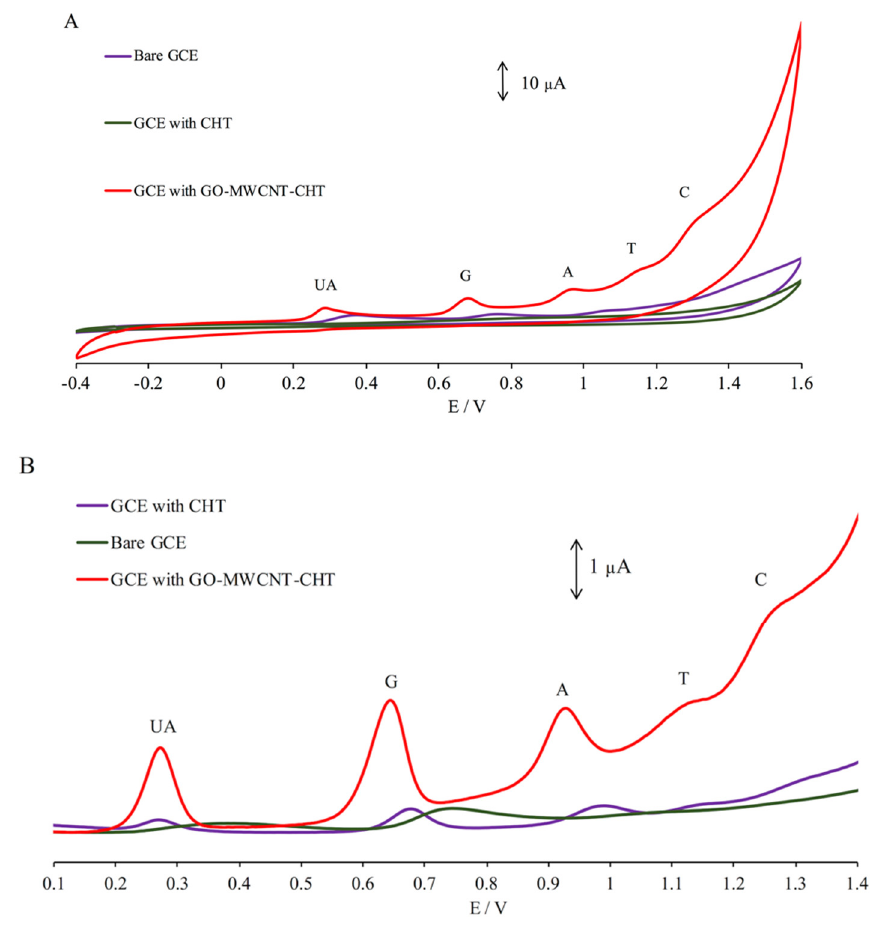
Figure 5. ( A ) Comparison of CV using bare GCE, GCE / CHT, and the GCE / GO-MWCNT-CHT to detect Figure 5. ( a ) Comparison of CV using bare GCE, GCE/CHT, and the GCE/GO ‐ MWCNT ‐ CHT to detect 175 µ M UA, 50 µ M G, 50 µ M A, 250 µ M T, and 250 µ M C in 0.2 M PBS (pH 7.0); ( B ) comparison of DPV 175 μ M UA, 50 μ M G, 50 μ M A, 250 μ M T, and 250 μ M C in 0.2 M PBS (pH 7.0); ( b ) comparison of using bare GCE, GCE / CHT, and the GCE / GO-MWCNT-CHT to detect 15 µ M UA, 15 µ M G, 15 µ M A, DPV using bare GCE, GCE/CHT, and the GCE/GO ‐ MWCNT ‐ CHT to detect 15 μ M UA, 15 μ M G, 15 35 µ M T, and 35 µ M C in 0.2 M PBS (pH μ M A, 35 μ M T, and 35 μ M C in 0.2 M PBS (pH 7.0).